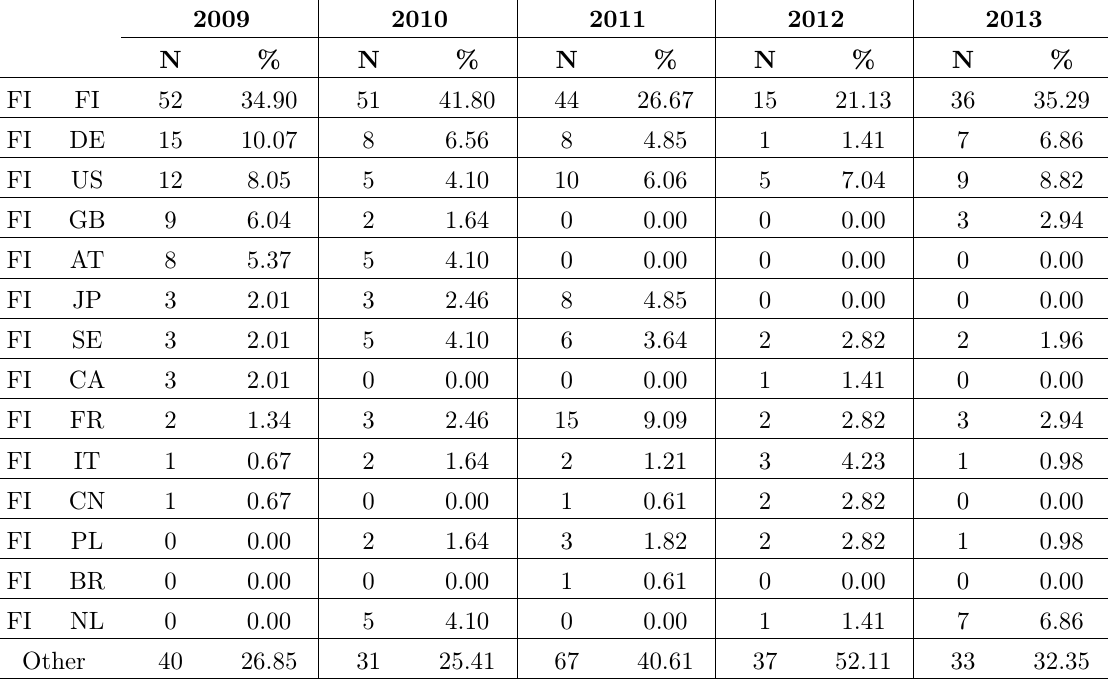
Table 4. Frequency table of the geographic distribution of the origins of the patent applicati-